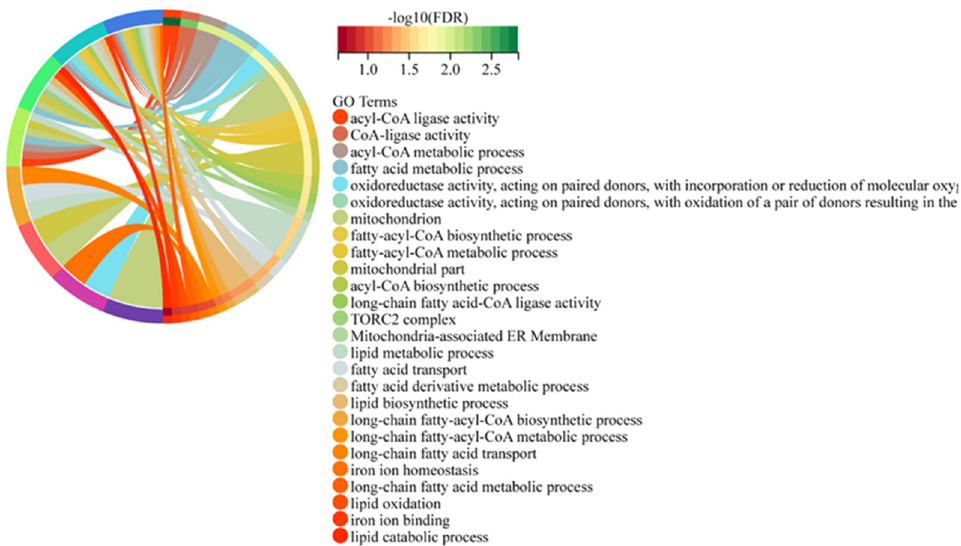
Figure 8. GO analysis of 11 co-expressed genes between ferroptosis-related genes and KIRC